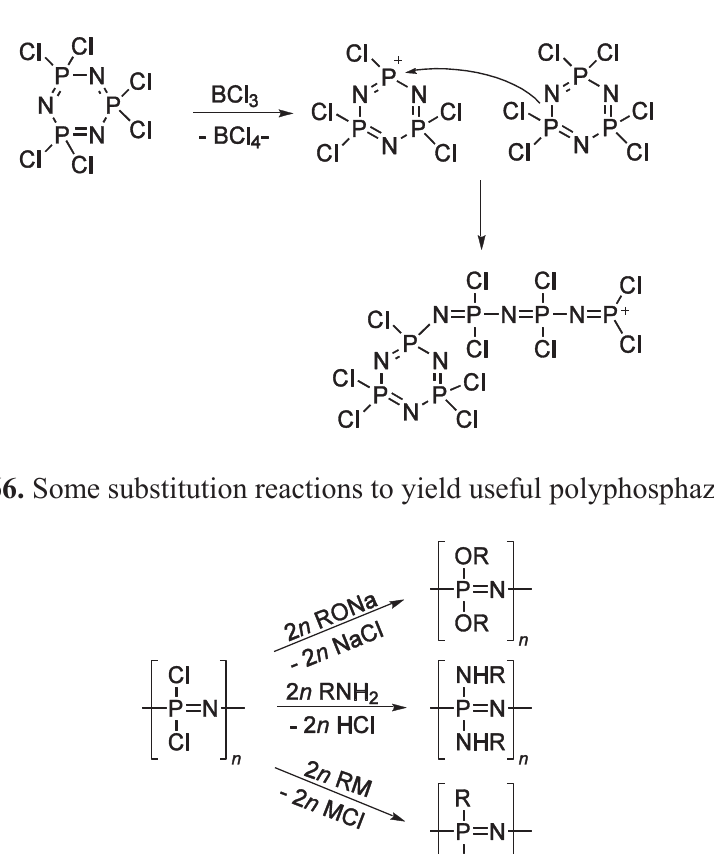
Figure 65. The cationic polymerization of hexachloro cyclo-triphosphazene.